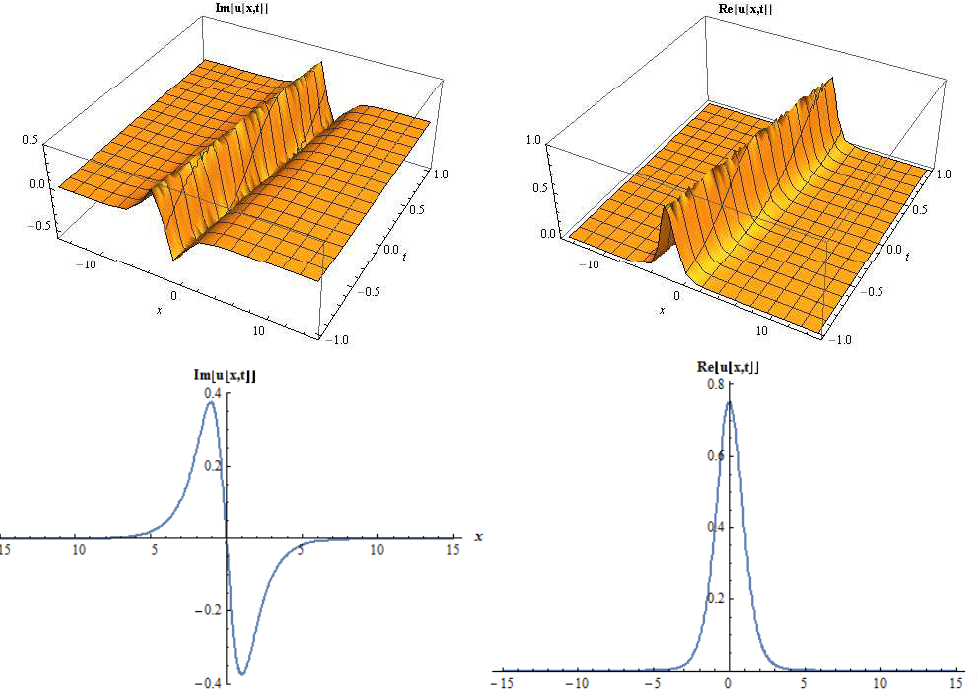
Fig. 4 The 3D and 2D surfaces of Eq. (18).